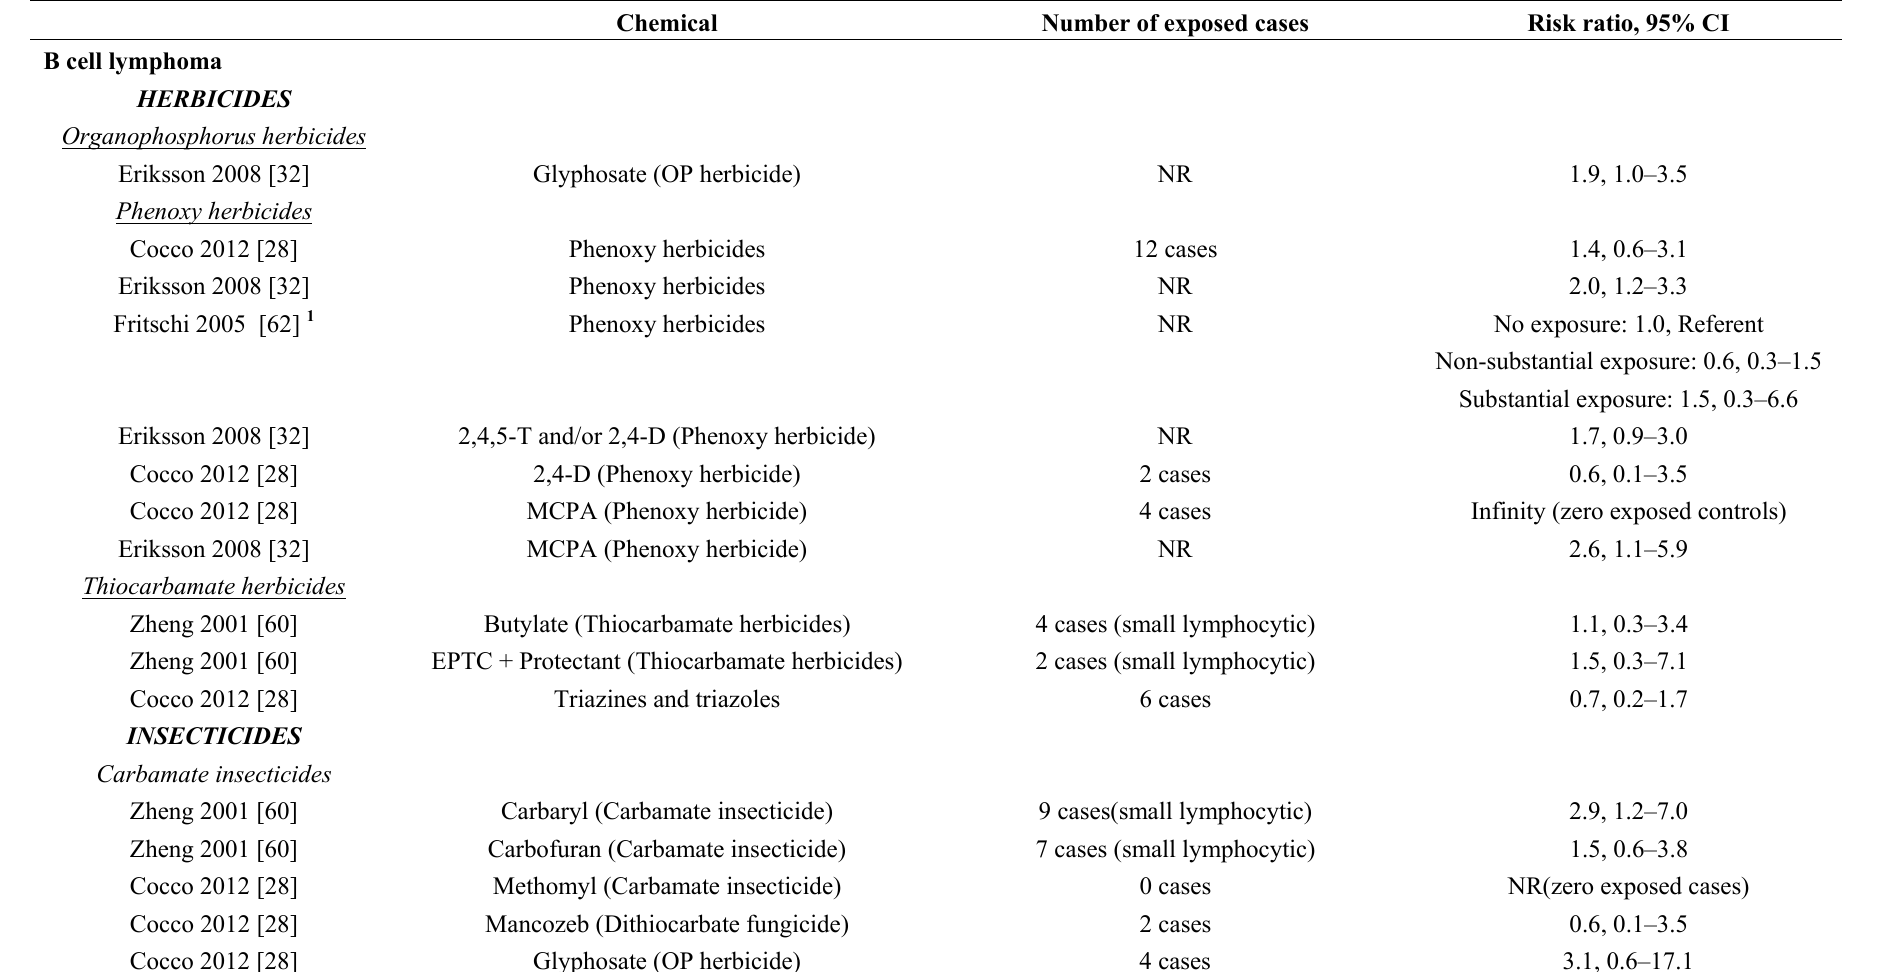
Table 3. Associations of subtypes of non-Hodgkin lymphoma with herbicides and insecticides. Chemical Number of exposed cases Risk ratio, 95%